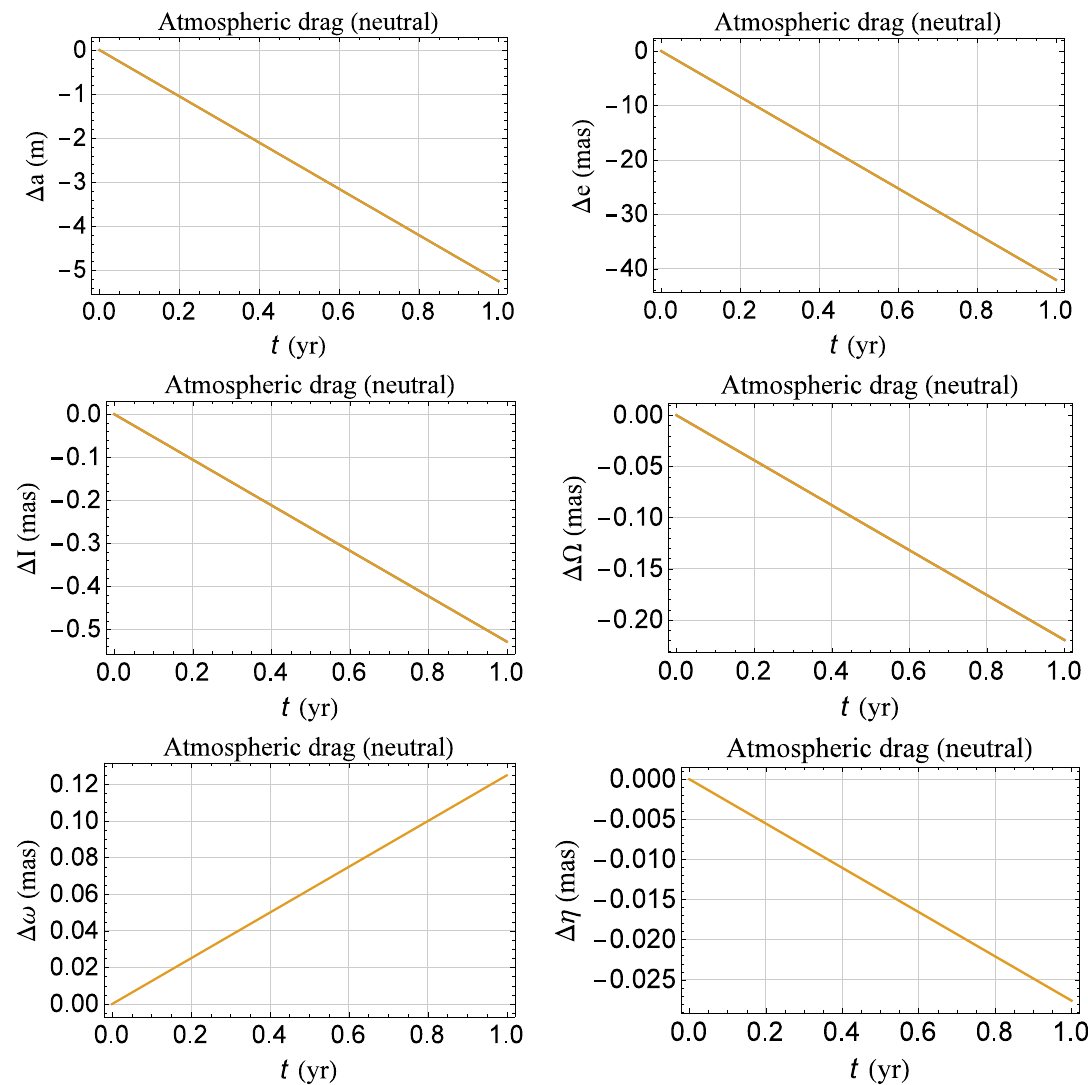
Figure A2. Numerically integrated shifts of the semimajor axis a , the eccentricity e , the longitude of the ascending node Ω , the argument of the perigee ω , and the mean anomaly at epoch η for the orbital configuration of TableA2. For the satellite, assumed spherical in shape and passive, we adopted C D = 3.5, Σ = 2.69 × 10 − 4 as for the existing LARES [53]. In regard to the Earth’s atmospheric density, we adopted r 0 = r min = a ( 1 − e ) = 1046.86km, ρ 0 = ρ max = 7.3 × 10 − 15 kgm − 3 , λ = 872.87km. Cfr. with the semi-analytical results of FigureA1 and Table